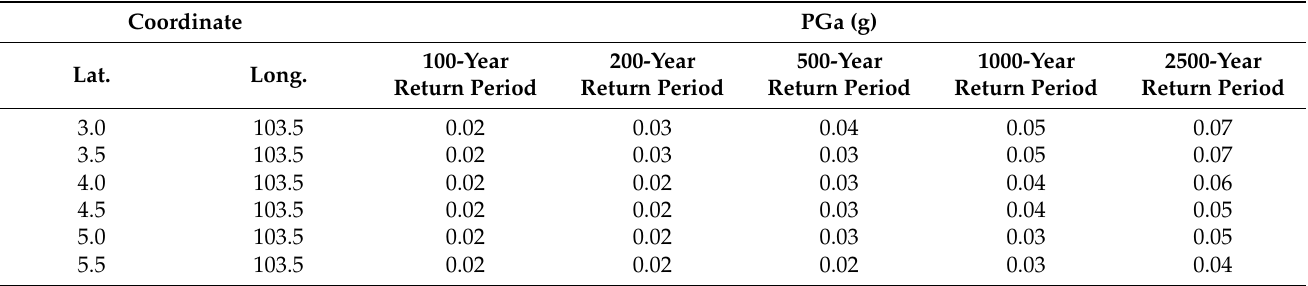
Table 3. PGa values for offshore Peninsular Malaysia